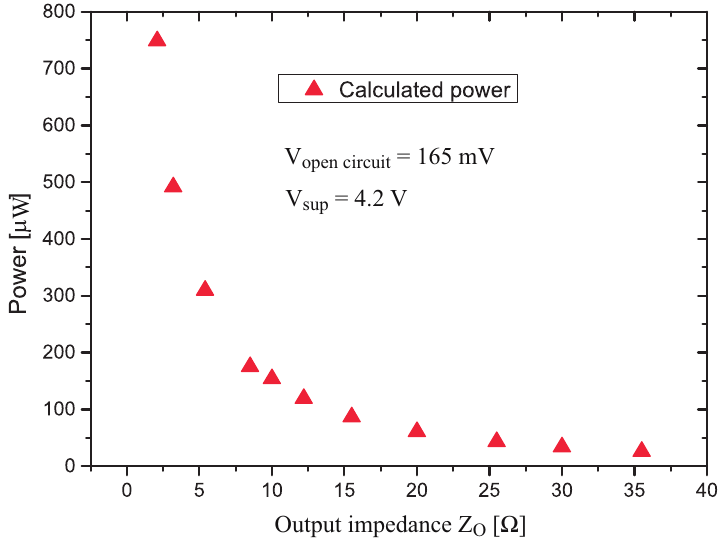
Figure 8. Calculated DC–DC converter output power with a fixed input voltage ( V in = 165 mV) and series resistors in the range 2.1 to 35.5 Ω